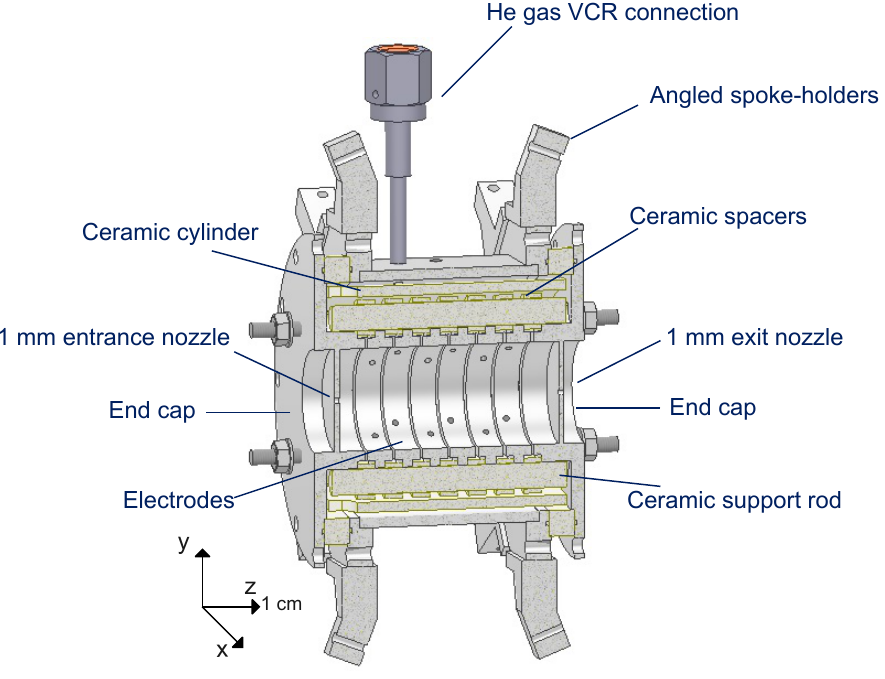
Figure 3. 3D cross-sectional view of the LRC drift tube and its